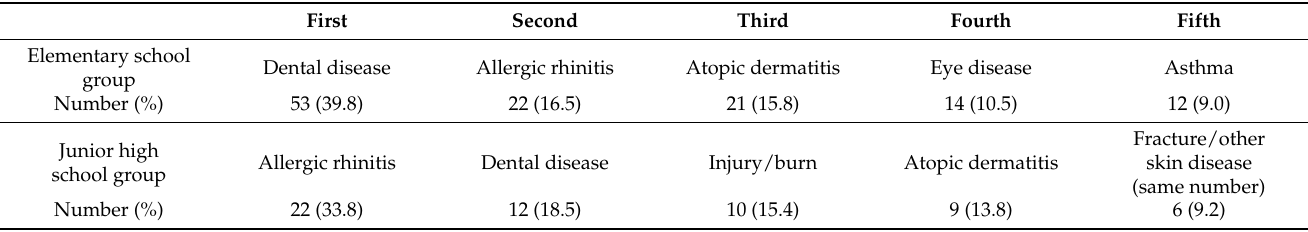
Table 4. Top five highest ranked diseases requiring hospital visits by age group.